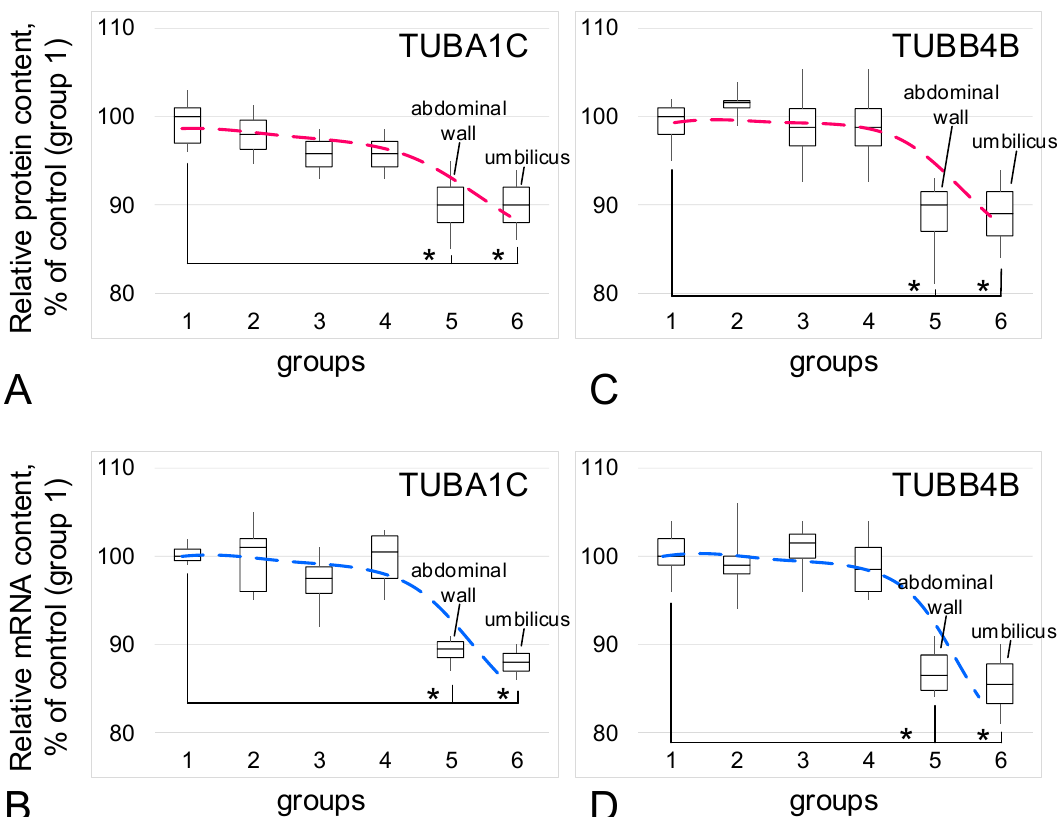
Figure 4. Relative content of tubulin isoforms and its mRNA. ( A )—Alpha-tubulin (TUBA1C) protein. ( B )—alpha-tubulin mRNA. ( C )—Beta-tubulin (TUBB4B) protein. ( D )—Beta-tubulin mRNA. *— p < 0.05 in comparison with control group 1 (women in postmenopause without endometriosis in their anamnesis). Red and blue dashed lines reflect trends in protein and mRNA content, respectively. Group designations are the same as above.